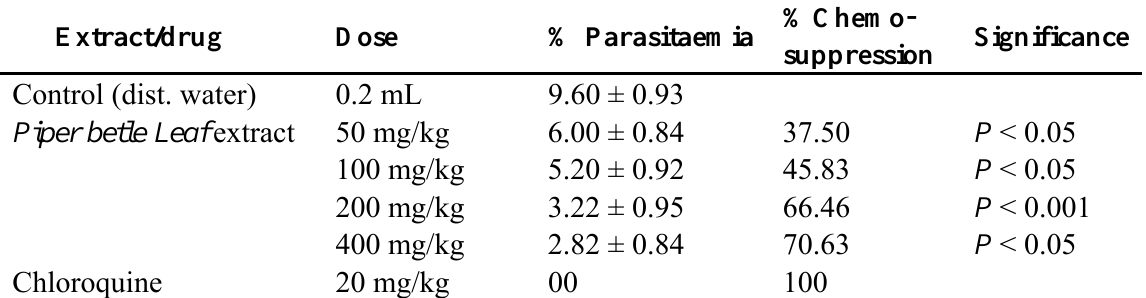
Table 2. Activity of Piper betle on established malaria infection.